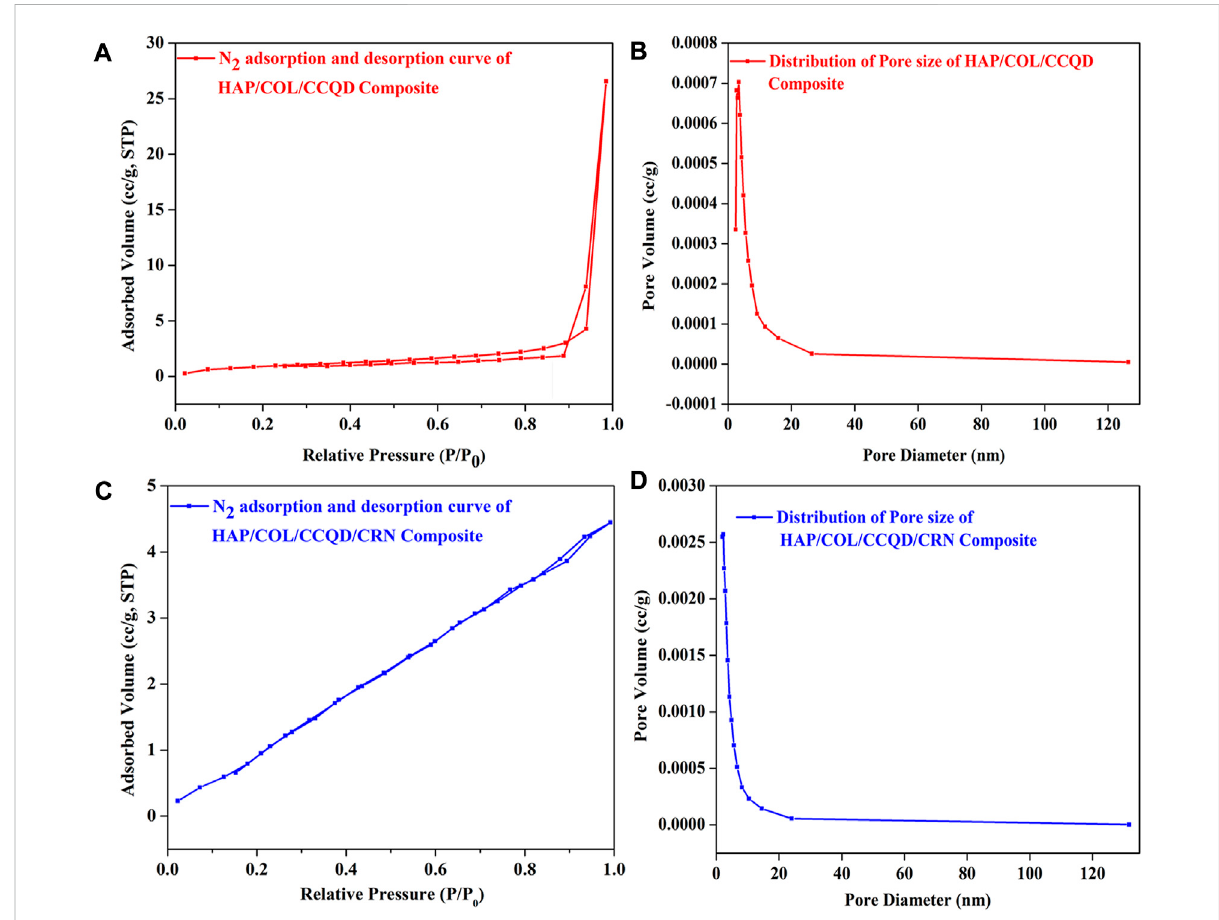
FIGURE 7 (A) N 2 adsorption and desorption isotherm of HAP/COL/CCQD composite, (B) N 2 adsorption and desorption isotherm of CRN loaded HAP/ COL/CCQD composite, (C) Pore size distribution curve of HAP/COL/CCQD composite and (D) Pore size distribution curve of CRN loaded HAP/ COL/CCQD